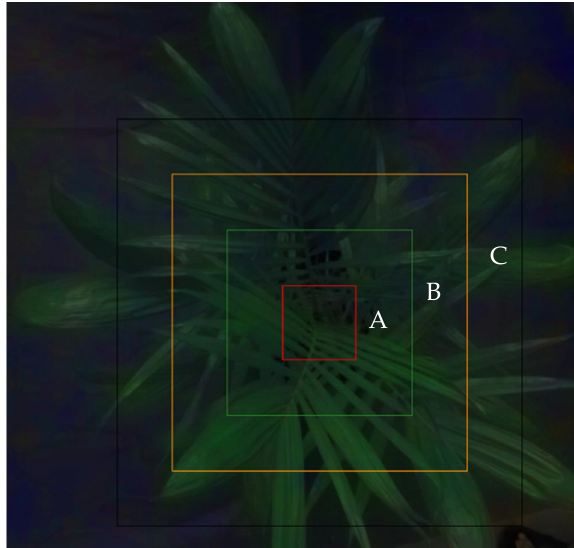
Figure 2. The three regions of interest.